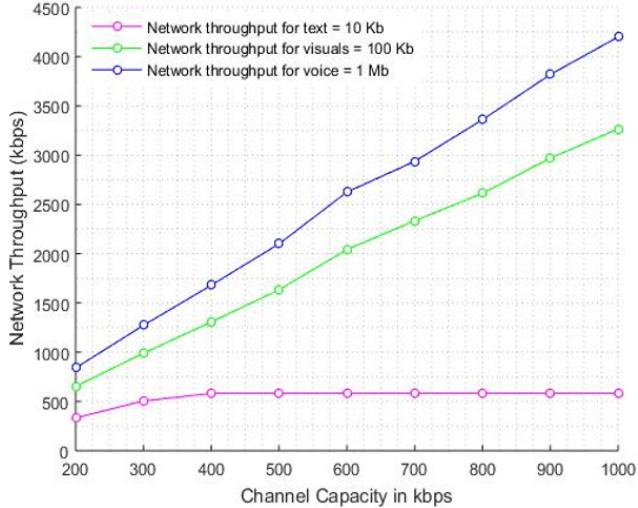
Figure 20. Network throughput of proposed design with different data types for N = 30.